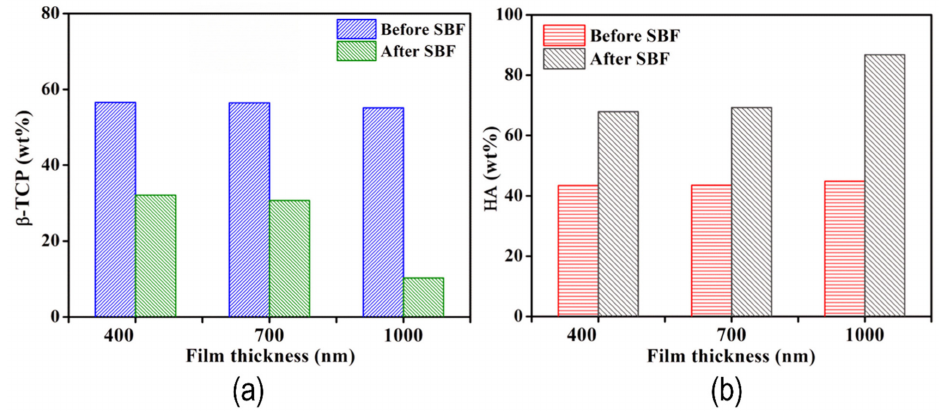
Figure 1. The weight percentage of ( a ) β TCP ( b ) HA of a film with different thicknesses. Reprinted with permission from [86].